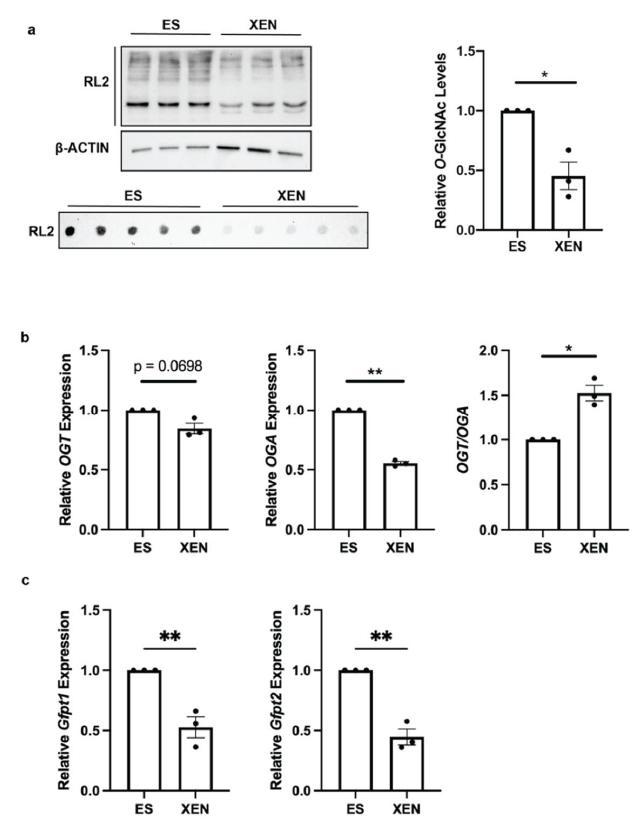
Figure 1. Global O -GlcNAcylation is decreased in XEN compared to ES cells: ( a ) Western blot, immunodot blot, and immunodot blot densitometry of O -GlcNAcylated proteins from ESC and XEN cells detected by the RL2 antibody; ( b ) expression levels and ratio of Ogt and Oga transcripts and ( c ) expression levels of Gfpt1 and Gfpt2 in ES and XEN cells as detected by RT-qPCR. Bars represent mean ± SEM, N = 3. * p < 0.05, ** p <